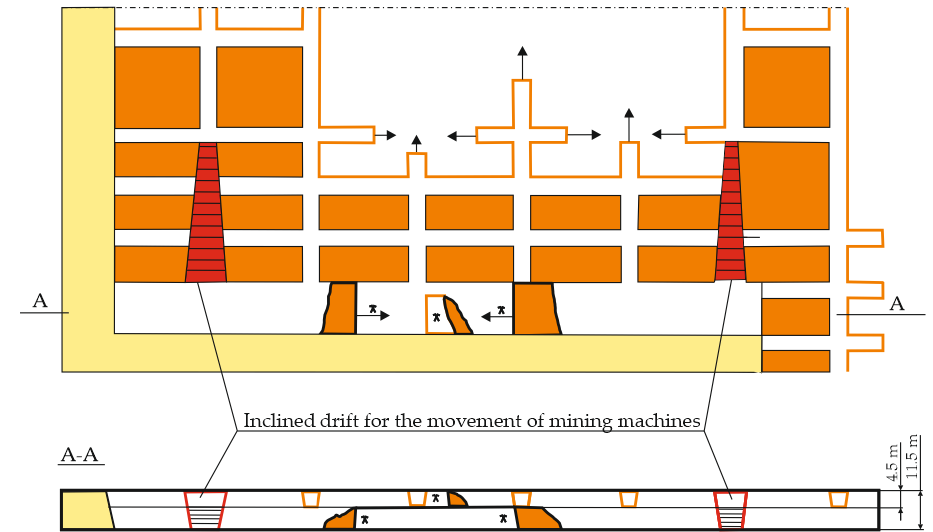
Figure 15. Room and pillar mining method using two-layer orebody